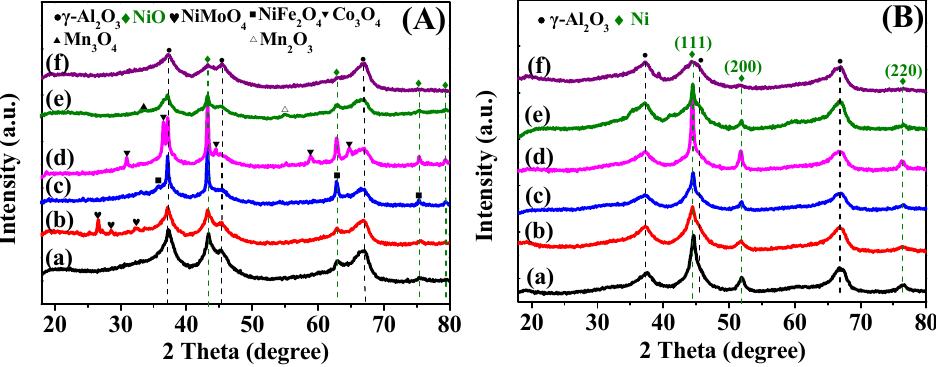
Figure 2. XRD patterns of the as ‐ prepared catalysts ( A ) and reduced catalysts ( B ): (a) 15Ni, (b) 15Ni ‐ 3Mo, (c) 15Ni ‐ 3Fe, (d) 15Ni ‐ 3Co, (e) 15Ni ‐ 3Mn and (f) 15Ni ‐ 3Cr.